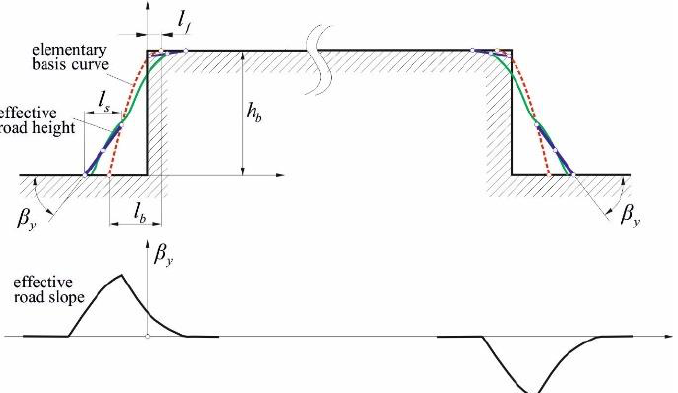
Figure 4. The use of the two-point follower technique to determine the wheel axle lift and angle of inclination of the effective road plane [20].